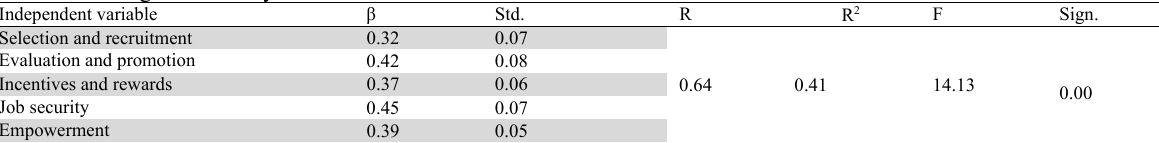
The results of regression analysis Independent variable